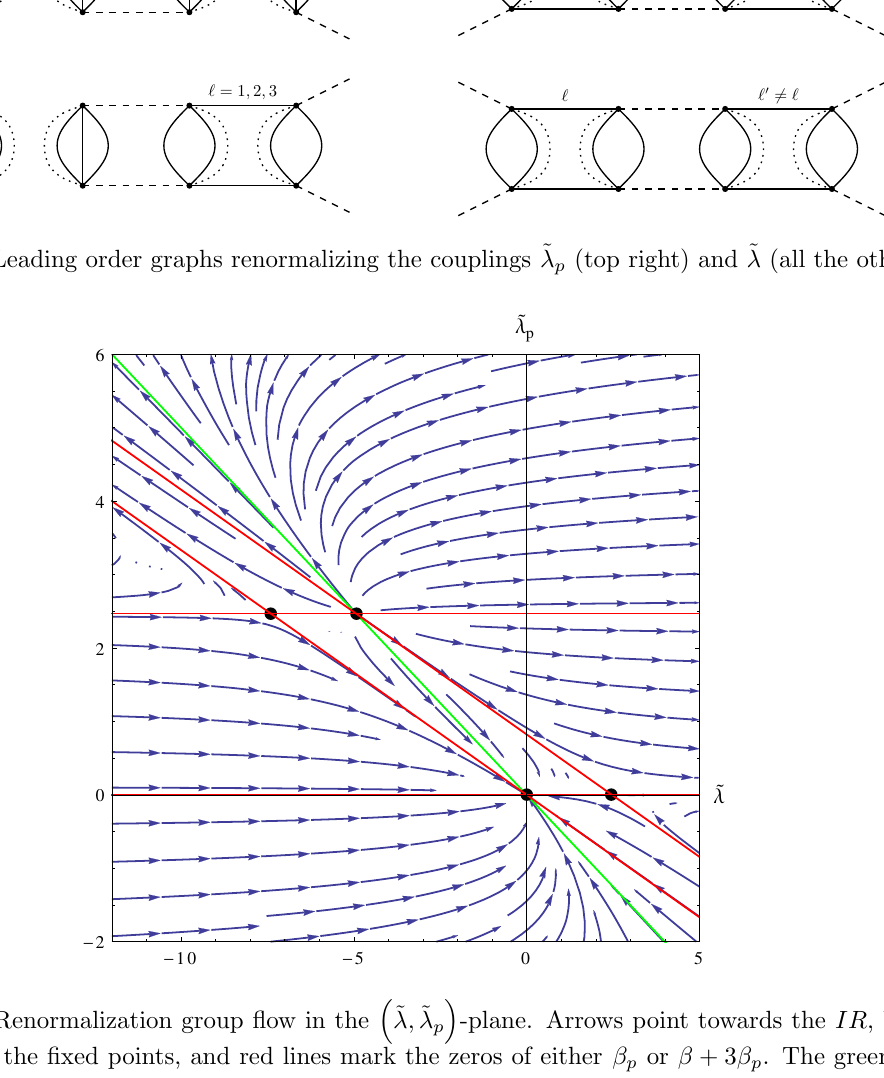
Figure 8 . Renormalization group (cid:13)ow in the dots denote the (cid:12)xed points, and red lines mark the zeros of either (cid:12) p or (cid:12) + 3 (cid:12) p . The green line corresponds instead to (cid:12) + 2 (cid:12) p = 0, which morally replaces the vertical line (cid:12) = 0 of (cid:12)gure